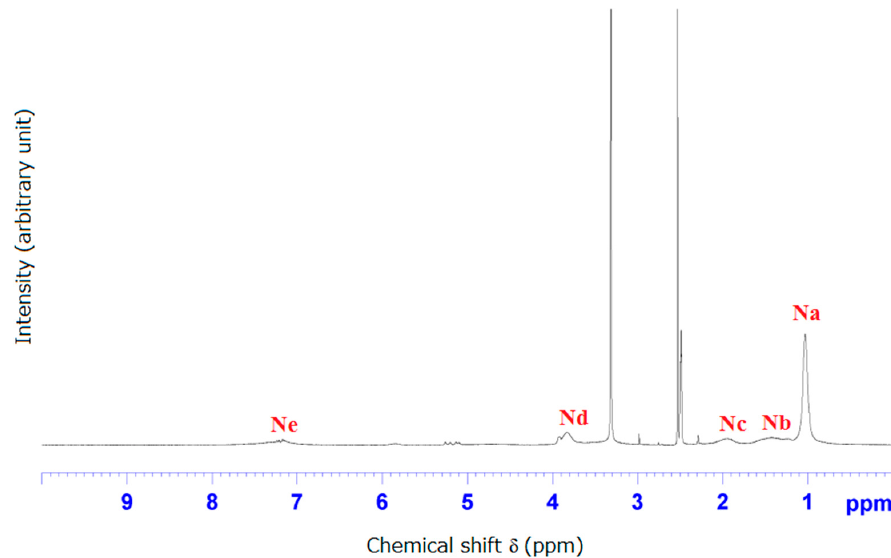
Figure 3. 1 H-NMR spectrum of poly(CD-NIPAM).